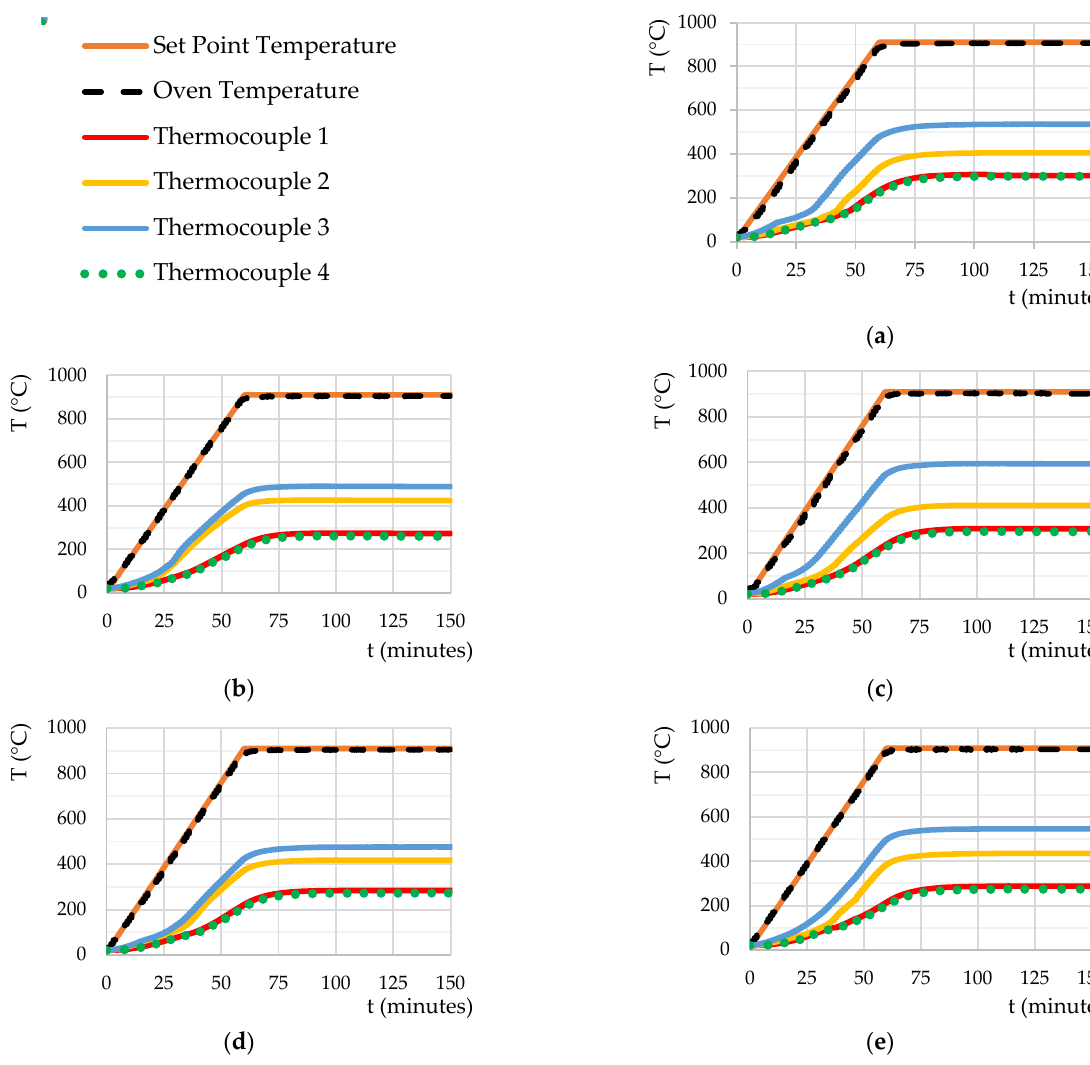
Figure 9. Temperature evolution in the tested SP: ( a ) Specimen 26 of CM; ( b ) Specimen 30 of DCM; ( c ) Specimen 36 of DGMP; ( d ) Specimen 40 of DGMV; ( e ) Specimen 48 of DRCM.